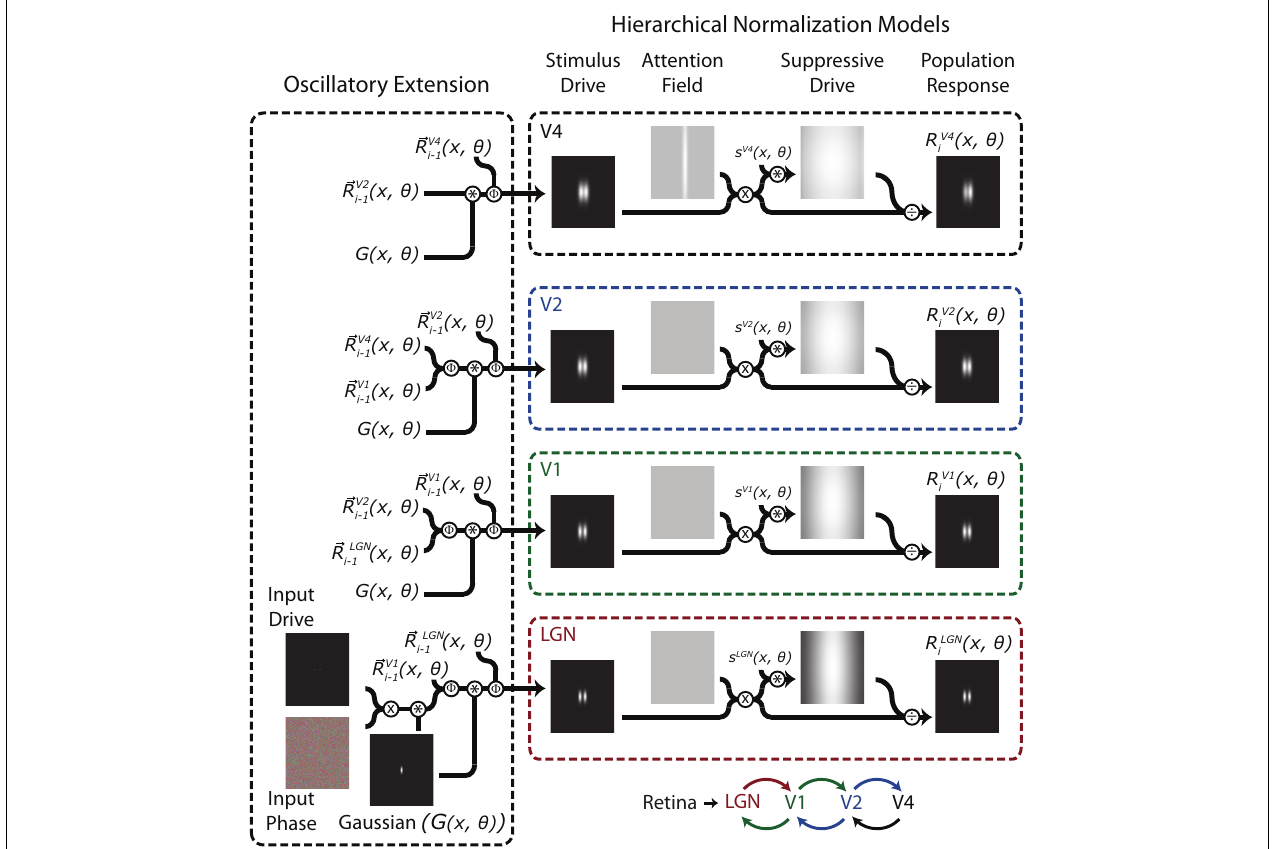
The normalization model (see Figure 3 ) then outputs a population response (cid:2) (cid:3) ( x , θ ) R LGN which spreads to higher areas on subsequent iterations. OnlyV4 1 has a non-uniform attention field, so attentional modulation only occurs after bottom-up activation has reachedV4.The biased output ofV4 is then relayed back to lower cortical areas where it creates attention-driven biases at each of these areas.The connection diagram is shown in the lower right of the figure. A more complete description of the Oscillatory Extension is given in the text. Encircled x indicates multiplication; encircled ∗ indicates convolution; encircled ÷ indicates division; and encircled Φ indicates the calculation of vector means, as described in the